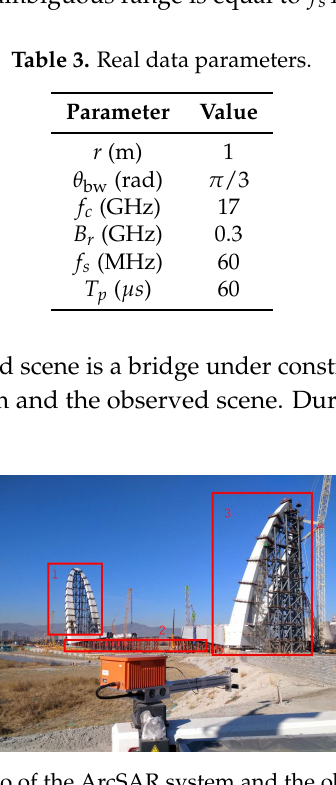
Figure 11. Photo of the ArcSAR system and the observed